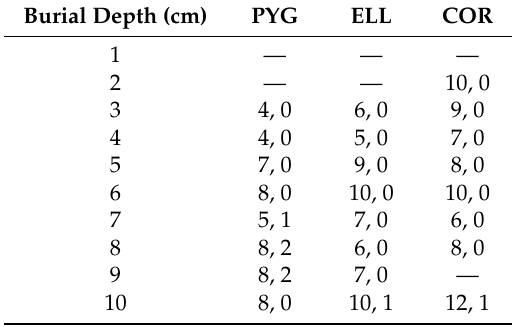
Figure 11. Escape potential of the three test species in coarse sand (0 Φ ≥ grain size ≥ 1 Φ ) expressed as